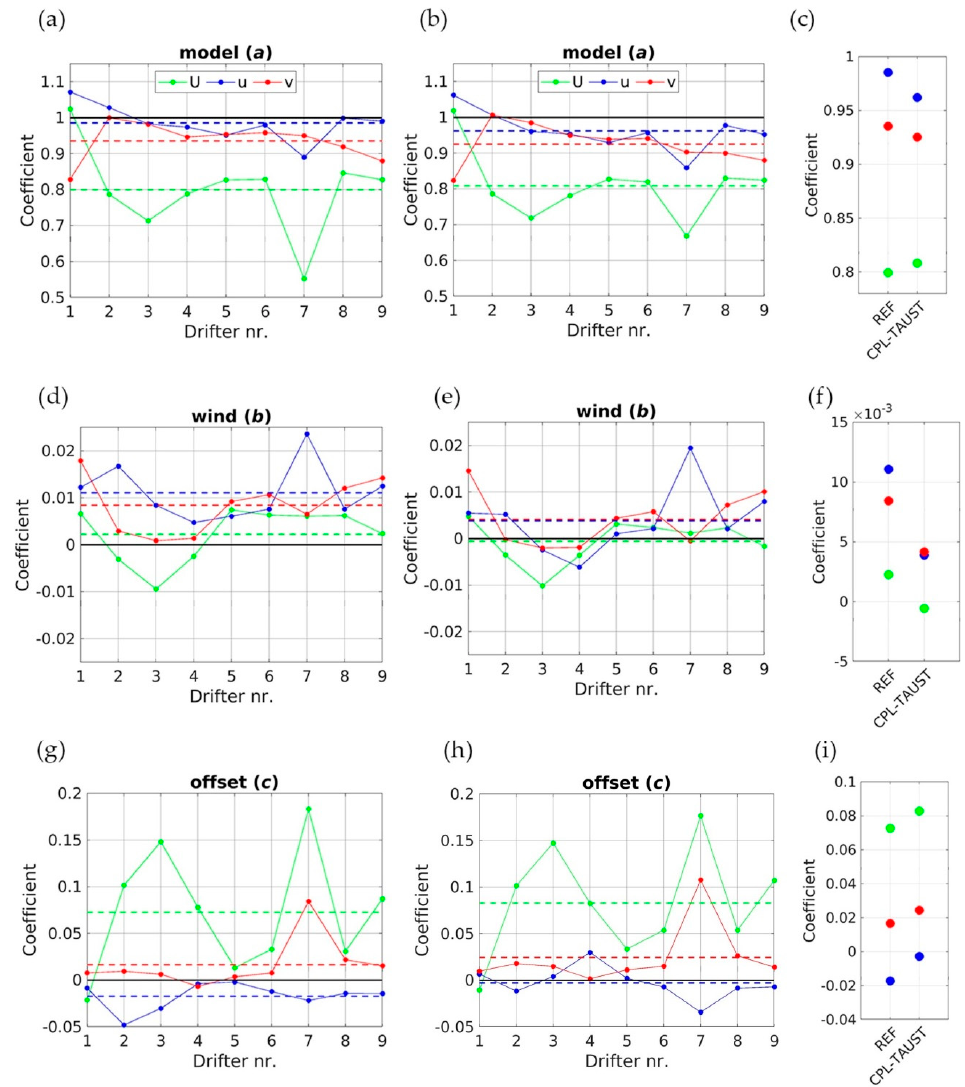
Figure 4. A multi-linear regression. The coefficients for each drifter and velocity component (solid lines) and the mean of all drifters (dashed lines). Without wave coupling (REF) ( a , d , g ) and with wave coupling (CPL-TAUST) ( b , e , h ). The averages for all drifters are shown in ( c , f , i ).